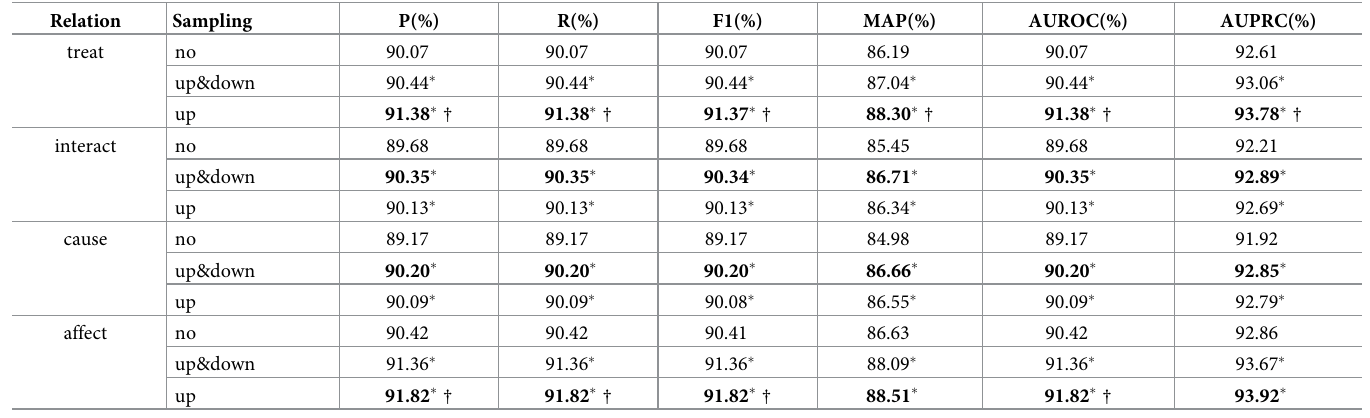
Table 8. The edge prediction results of COS using different sampling